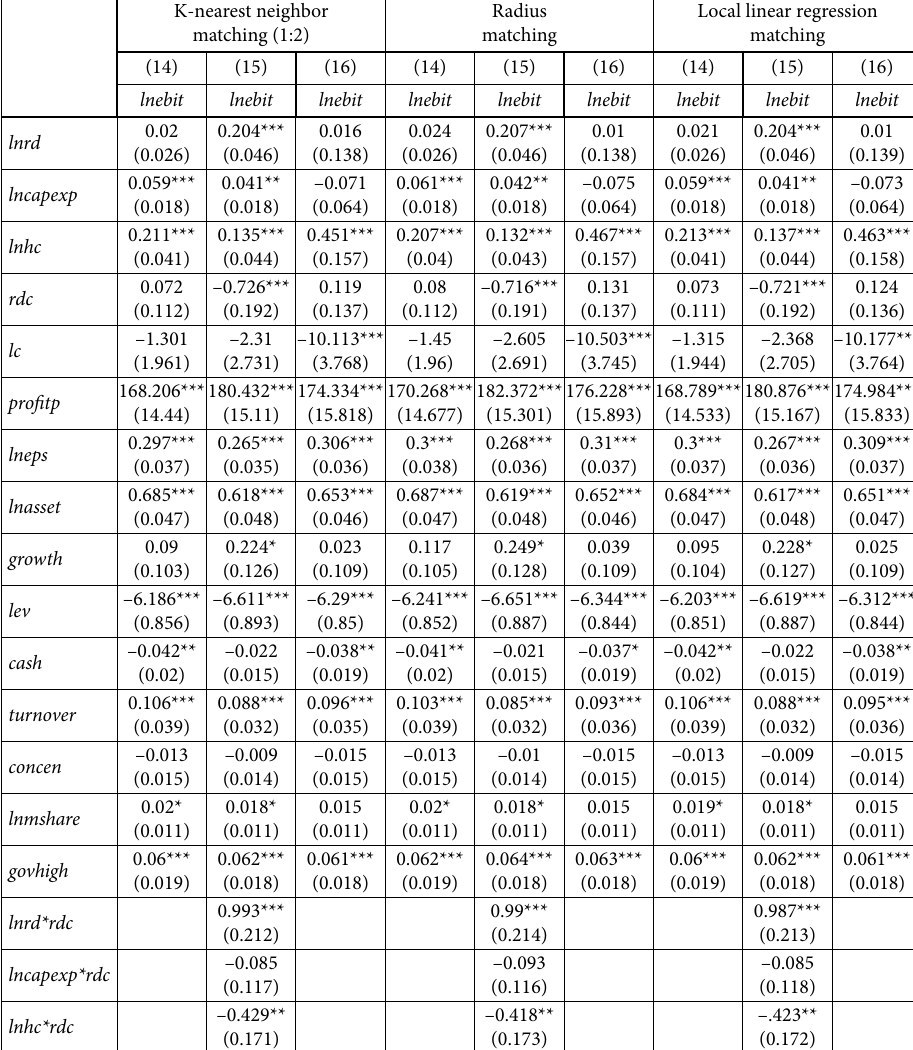
Table A3. Robustness test for endogeneity problem (Propensity score matching method) K-nearest neighbor matching